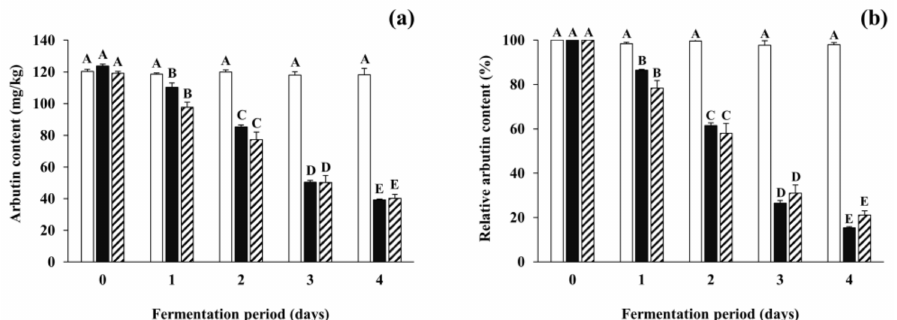
Figure 4. The degradation of arbutin spiked in soybeans fermented with arbutin-producing B. subtilis strains. ( a ) The total arbutin content (the total amount of arbutin naturally present in soybeans in addition to spiked arbutin); ( b ) the relative content of spiked arbutin. Arbutin was added in respective soybean samples at a concentration of 100 mg / kg. The relative content of arbutin was represented as the percentage of spiked arbutin content remaining in fermented or non-inoculated soybeans. □: control without an inoculum, ■ : positive control inoculated with B. subtilis KCTC 3135, ▨ : experimental samples (mean values). The mean values of striped bars were calculated from different experimental samples inoculated with each of the four B. subtilis strains ( B. subtilis CJ 151, TF 207, NT 424, and GJ 614). Values of bars in the same color with different letters (A–E) are significantly different ( p < 0.05). Error bars indicate standard deviations determined from duplicate experiments (control and positive control) or different experimental samples (experimental samples).